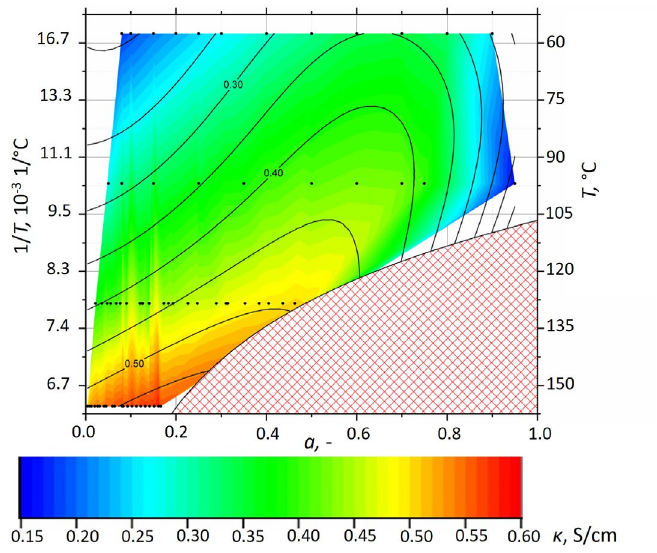
Fig. 5. 3D representation of the temperature and water activity dependence of the electrical conductivity κ (colour coded) of phosphoric acid solutions. See text for explanation of the cross-barred